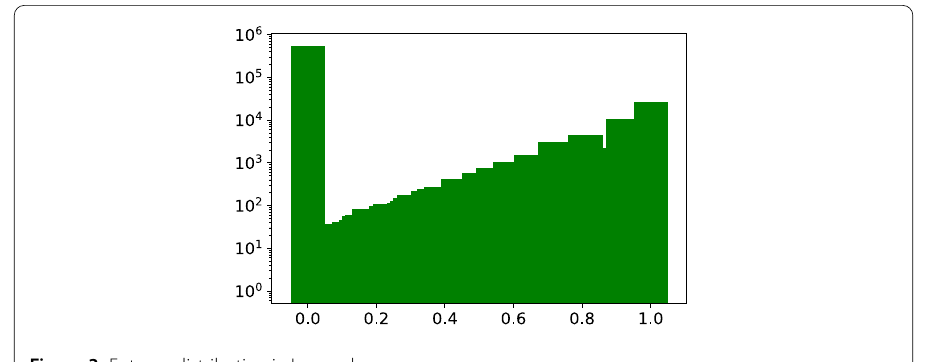
Figure 3 Entropy distribution in Log